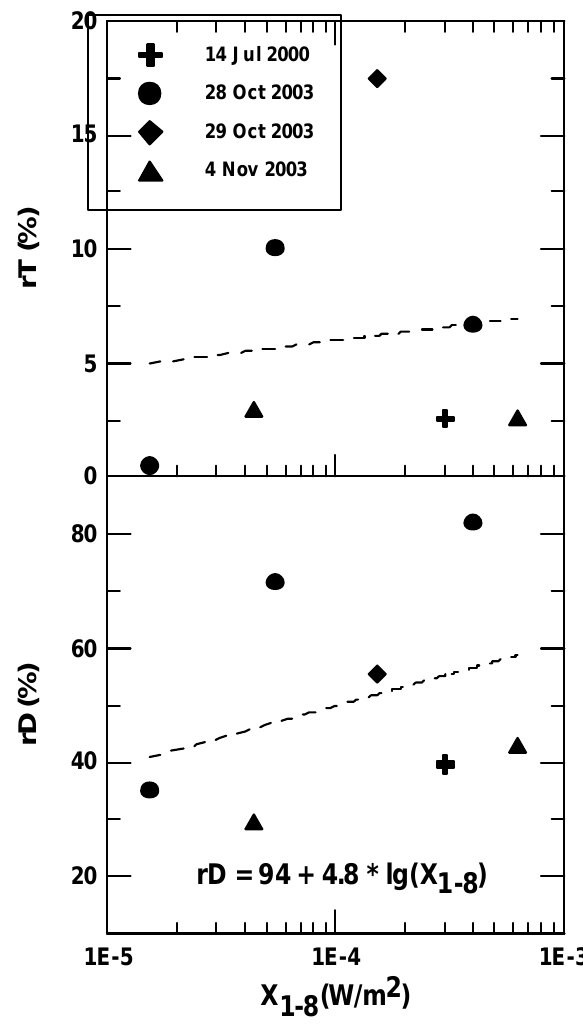
Fig. 9. Relative change in the topside ionospheric temperature (up- Figure 9. Relative change of the topside ionospheric temperature (upper panel) and ion per panel) and ion density (lower panel) versus solar 1–8 ˚A X-ray density (lower panel) versus solar 1-8 Å X-ray fluxes.